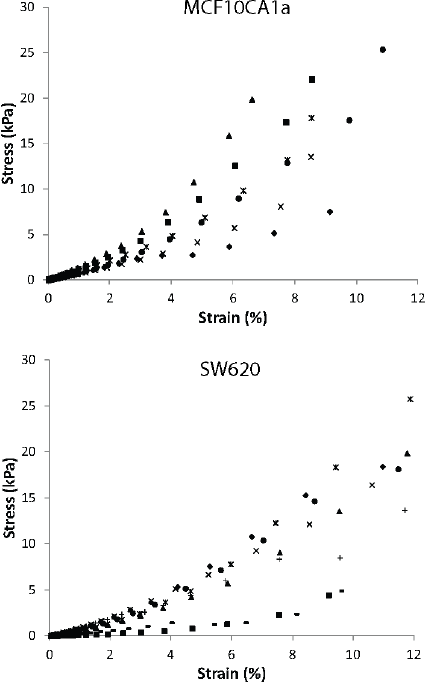
Figure 2. Stress-strain response of tumors. Experimentally measured elastic stress-strain response of MCF10CA1a and SW620 tumors in unconfined compression. Data show individual tumor